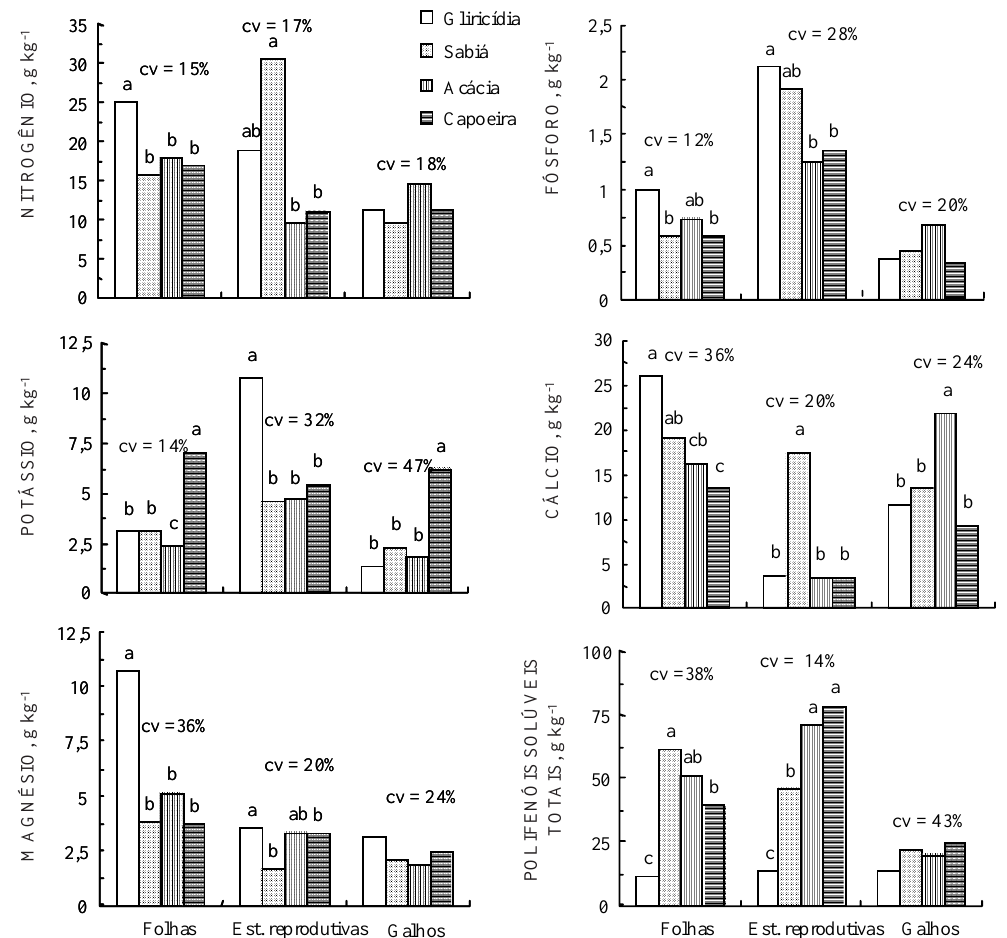
Figura 6. Composição química do material formador da serapilheira das leguminosas utilizadas na revegetação e da mistura de materiais das diferentes espécies que formavam a